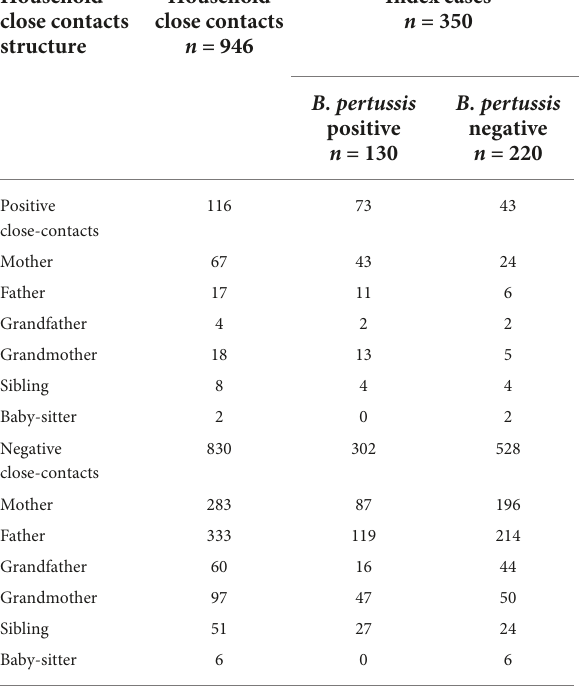
Household close contacts structure